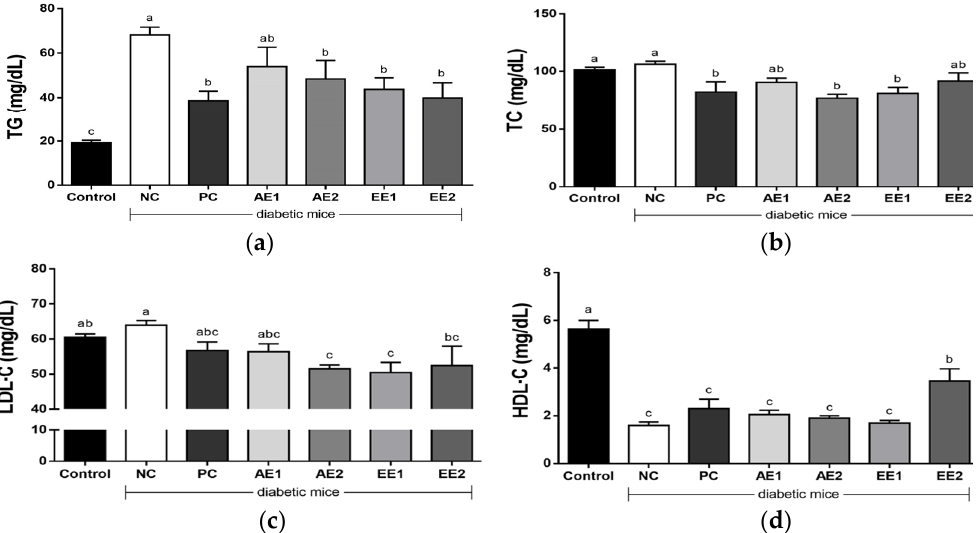
Figure 6. Effects of A. hookeri extracts on serum lipid profile in diabetic mice. ( a ) Triglyceride, ( b ) TC, ( c ) LDL-C, and ( d ) HDL-C. Control: non-diabetic mice; NC: negative control; PC: positive control, metformin 150 mg/kg BW; AE1: aqueous extract 100 mg/kg BW; AE2: aqueous extract 200 mg/kg BW; EE1: ethanol extract 100 mg/kg BW; EE2: ethanol extract 200 mg/kg BW. AE and EE groups were treated with A. hookeri extracts for 8 weeks. Data are presented as the mean ± SEM (n = 8). a–c Mean values with different letters are significantly different at p < 0.05.